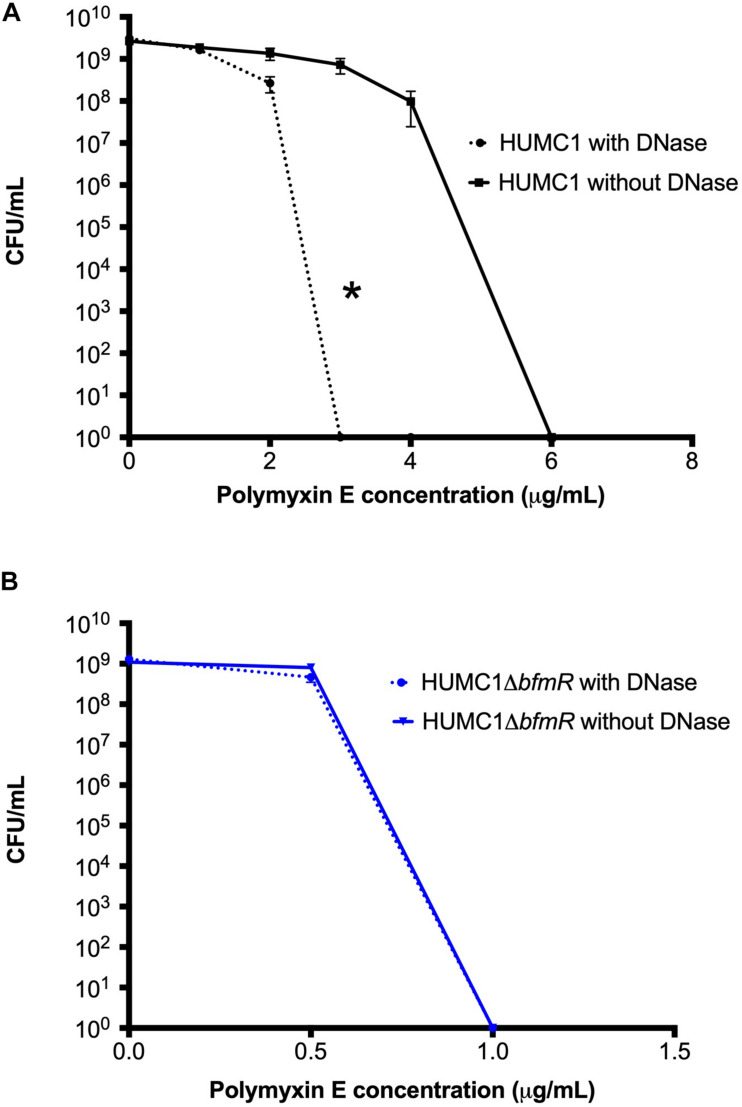
Panel A: Comparison of the growth/survival of HUMC1 in Mueller Hinton II cation-adjusted broth with and without 10 U/mL DNase in various concentrations of polymyxin E (0–8 μg/mL) after 24 h incubation at 37°C. Data are means ± SEM, n = 12, P = 0.0134, with comparisons of log-transformed AUC by unpaired t test. Panel (B) Comparison of the growth/survival of HUMC1 ΔbfmR in Mueller Hinton II cation-adjusted broth with and without 10 U/mL DNase in various concentrations of polymyxin E (0–1.5 μg/mL) after 24 h incubation at 37°C. Data are means ± SEM, n = 6, P = 0.1248, with comparisons of log-transformed AUC by unpaired t test.